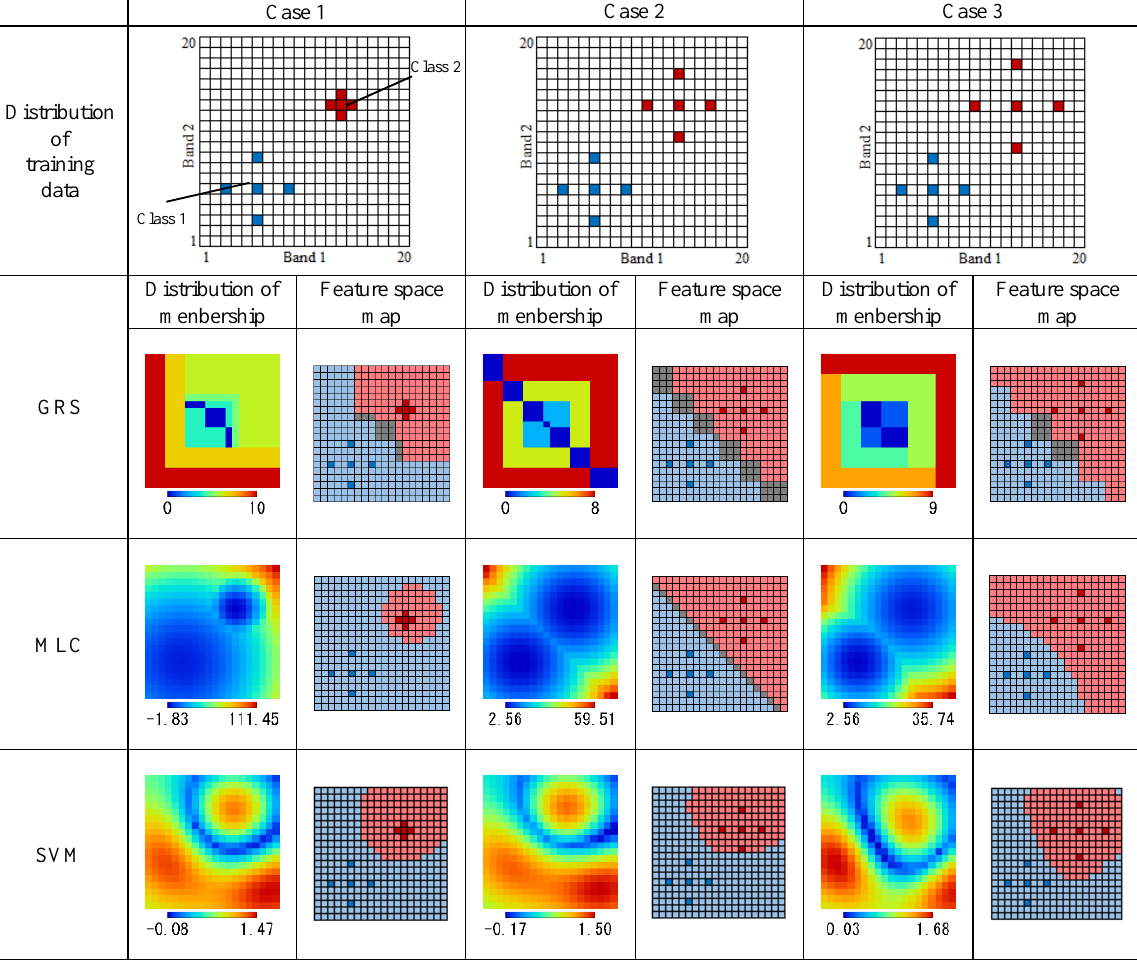
Figure 3. Distribution of training data, membership and classification map in feature space in three